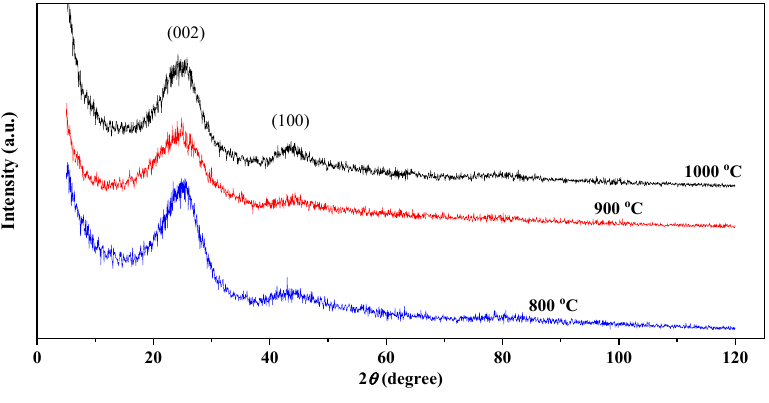
Figure 2. XRD of carbon fibers. To determine the composition of the crystalline and amorphous states of CNF, they were studied using powder X-ray diffraction patterns (Figure 2). The X-ray diffraction analysis of CNF illustrates the presence of two characteristic wide humps of carbon, including diffraction from {002} planes located at an angle of 24.7 ◦ , which indicates a disordered structure of carbon [34] and diffraction from planes {100} at an angle of 43.6 ◦ corresponding to the turbostratic carbon plane [35]. The broad shape of the peak around 24.1 ◦ indicates that the carbon nanofibers are mainly composed of amorphous carbon. The average distance between the layers {002} and {100} is calculated by the Bragg equation (Table